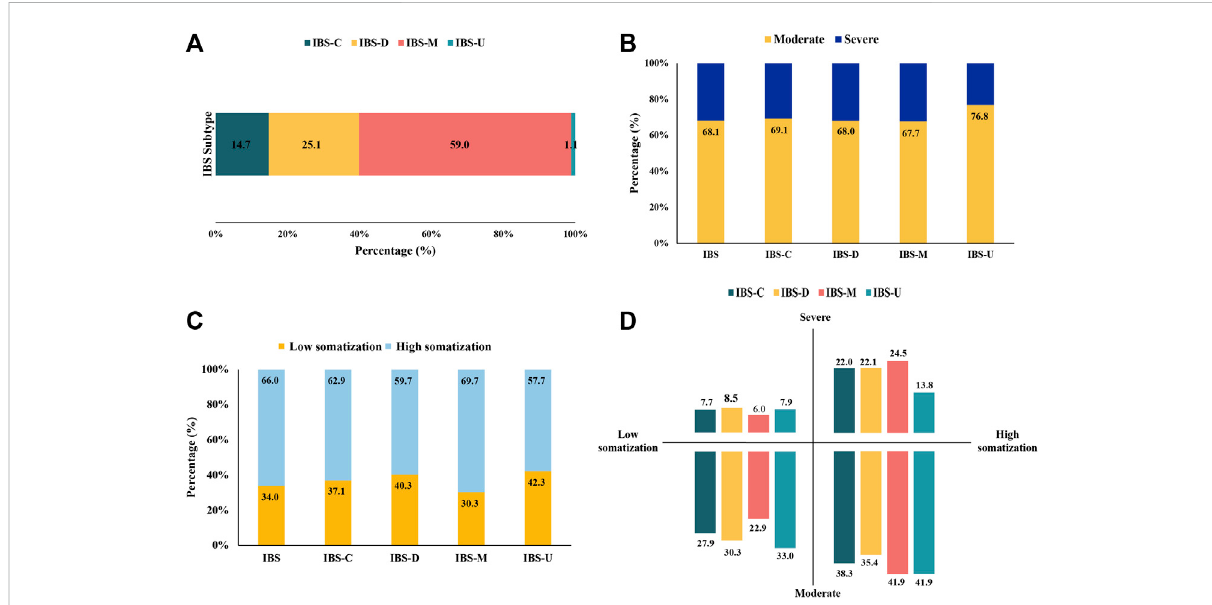
FIGURE 2 Distribution ofIBSsubtypesandsomatizationsymptoms.( n =17,695). (A) Proportionsofparticipantsde fi nedasIBSsubtypes. (B) Proportionsof IBS and its subtypes with moderate and severe symptoms. (C) Proportions of IBS and its subtypes with somatization. (D) Distribution of IBS subtypes in the fi eld of somatization and symptom